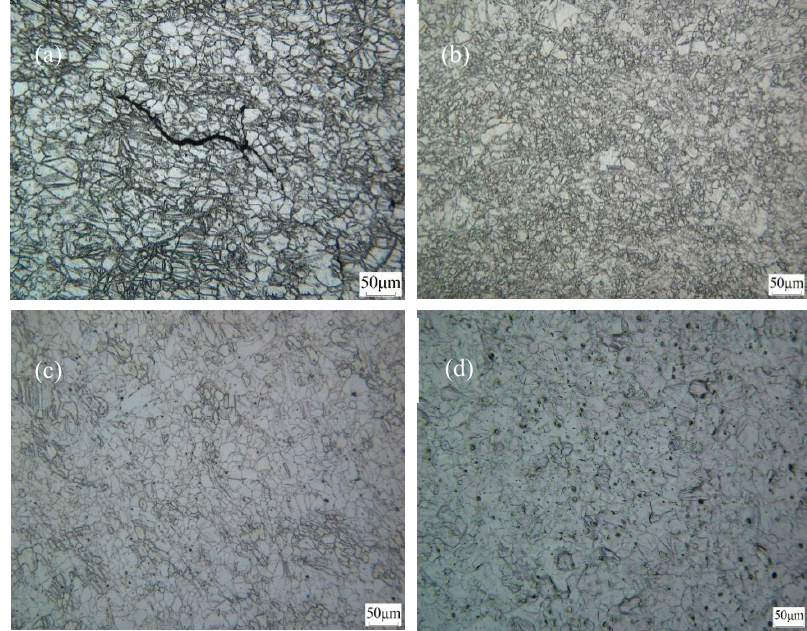
Figure 6. Optical microstructures of the deformed Mg-2Y-0.6Nd-0.6Zr alloy after ECAP at different temperatures: ( a ) 300 °C, ( b ) 320 °C, ( c ) 340 °C, and ( d ) 360 °C.